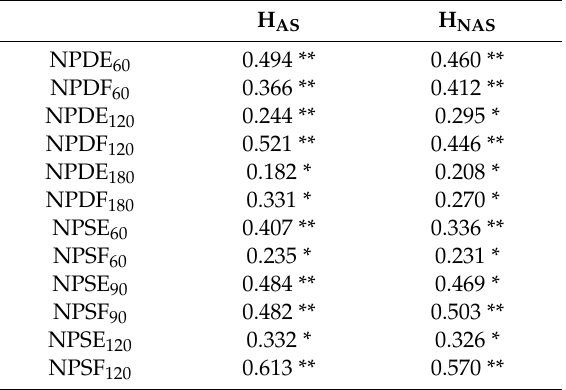
Table 2. Shared variance (R 2 ) between CMJ height and core strength measurements (n = 20).